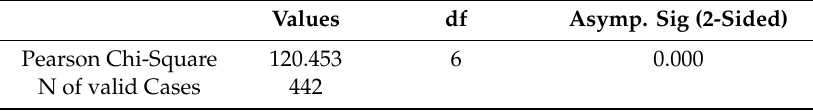
Table 1. Pear Chi-square Test statistics on age and house ownership.